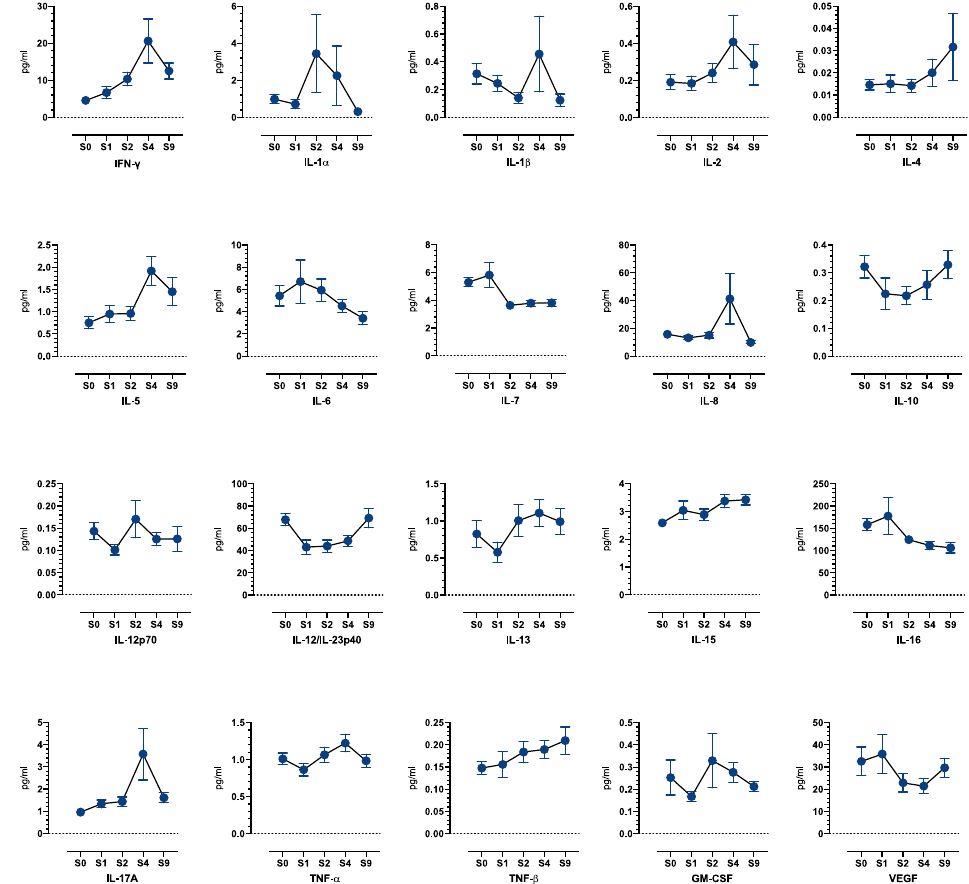
Figure 6. Blood biomarkers: Cytokines protein expression profile at baseline and after 9 cycles of induction treatment (N = 43).